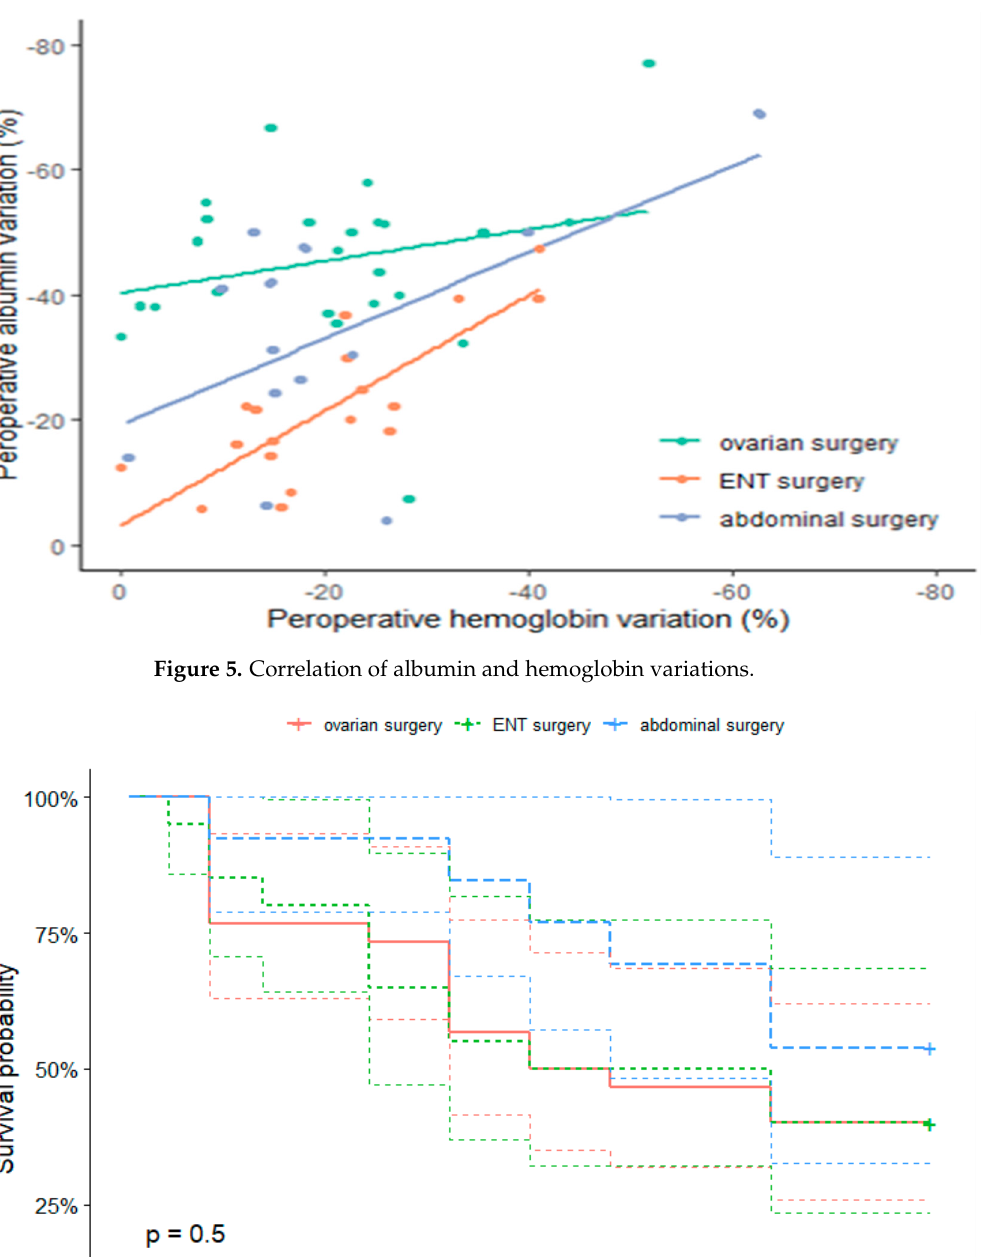
Figure 4. Comparison of the AUC of intraoperative variation of hemoglobin between surgery groups.